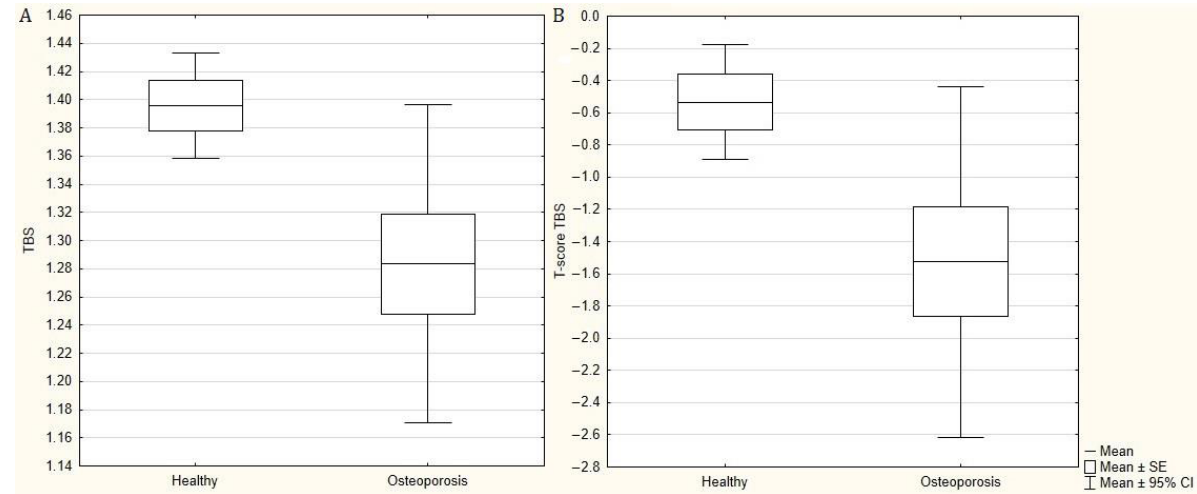
Figure 2. ( A ) Trabecular bone score (TBS) and ( B ) trabecular bone score T-score (T-score TBS) in patients with normal bone mineral density and with osteoporosis.